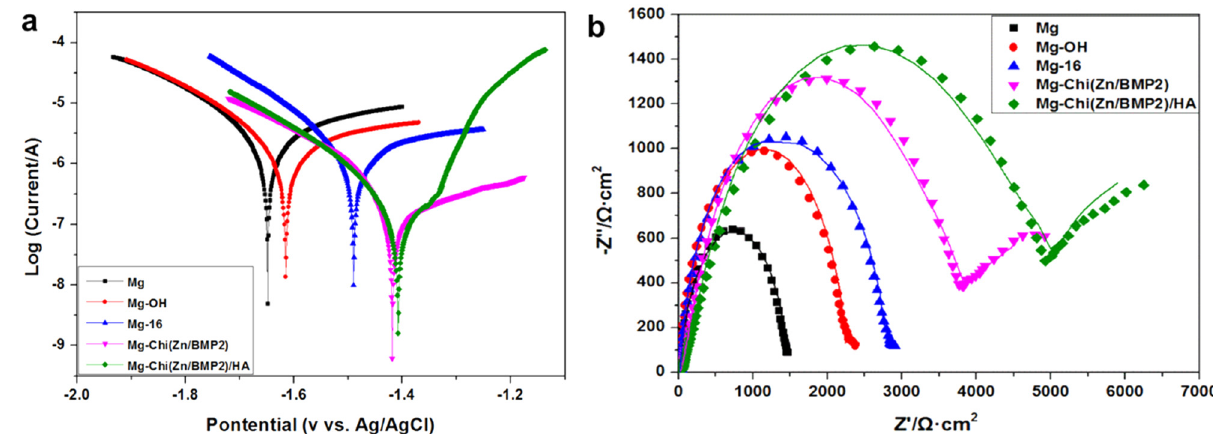
Figure 3: The electrochemical polarization curves and electrochemical impedance spectra ( EIS ) of the di ff erent samples.